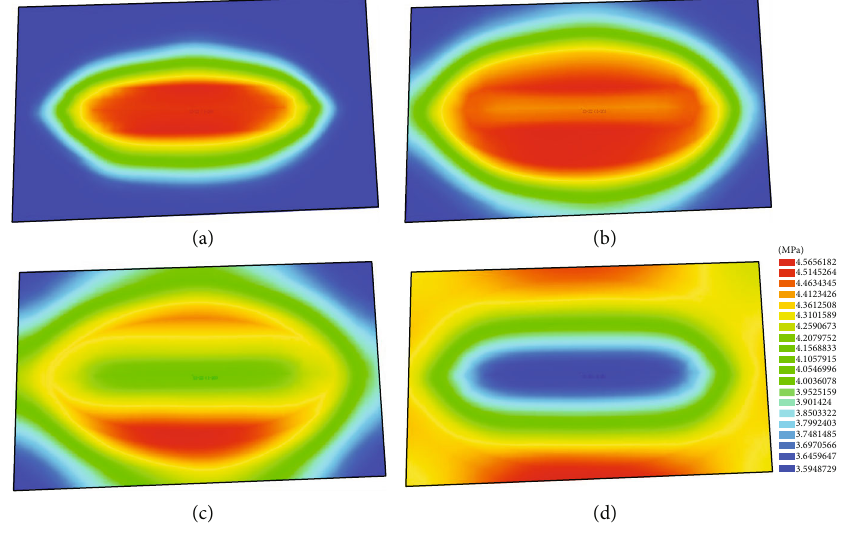
Figure 5: The fi rst stage fi tting pressure distribution. Table 3: Main parameters fi tted by di ff erent fracturing